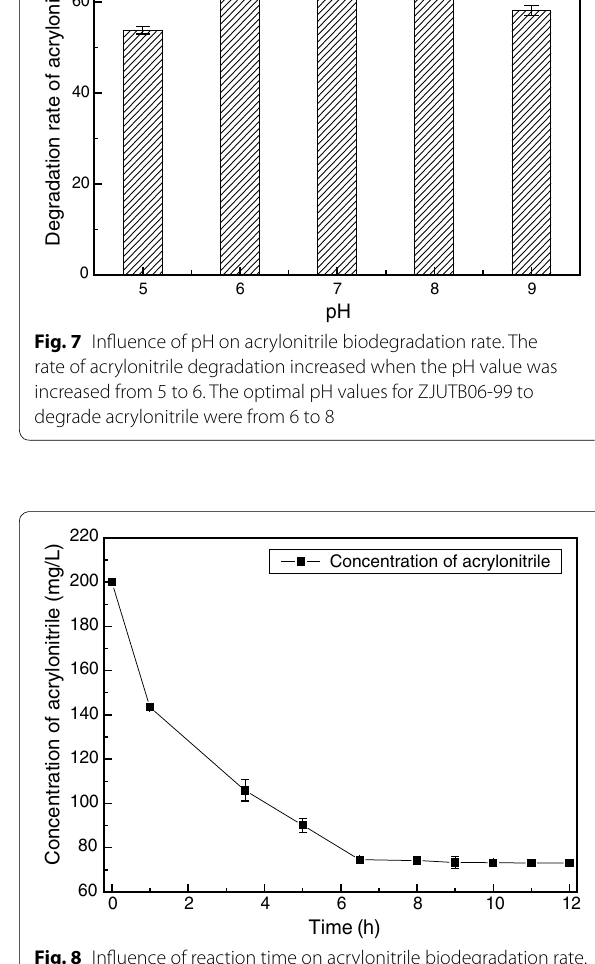
Fig. 8 Influence of reaction time on acrylonitrile biodegradation rate. The concentration of acrylonitrile was constantly decreasing with the increase of time. After 8 h, the residual of acrylonitrile decreased slowly and gradually became stable. The optimum biodegradation time was determined to be 8